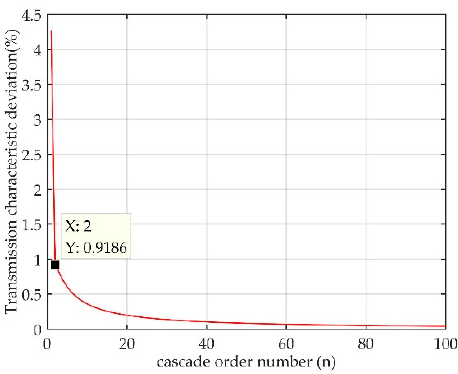
Figure 4. The maximum deviation of the transmission characteristics between the Gaussian filter and the approximating spline filter for different cascade orders.